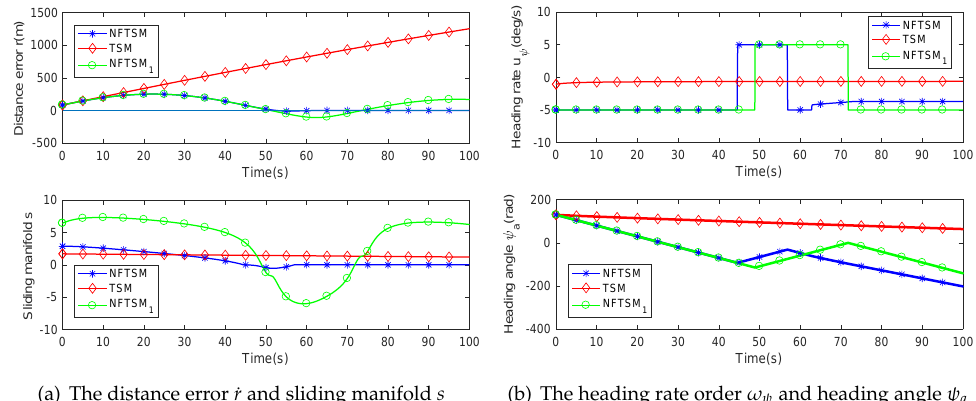
(b) The heading rate order ω ψ and heading angle ψ a Figure 6. The results of tracking a stationary target with ψ a = 130 ◦ .